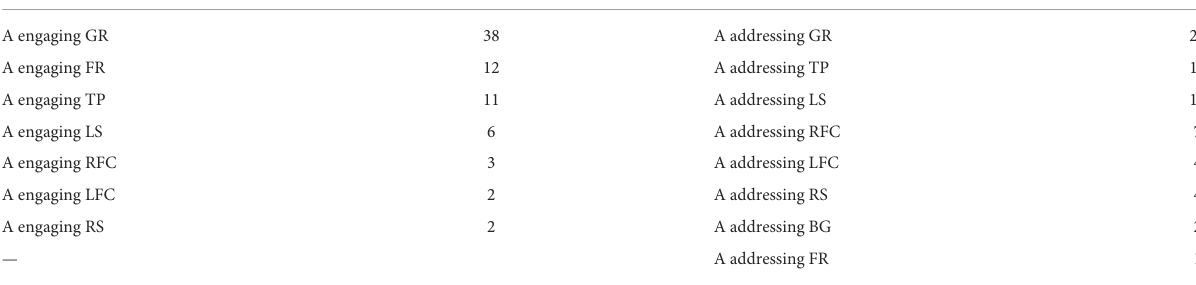
TABLE 3 Narrative projections of torso and